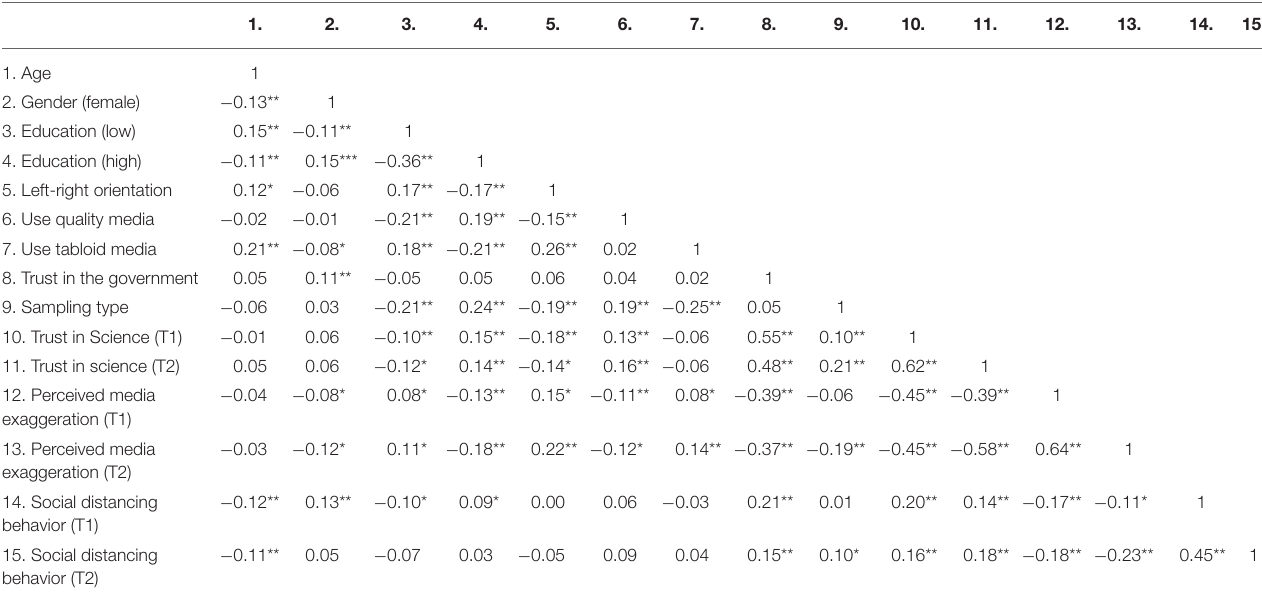
TABLE 1 | Pearson correlations.